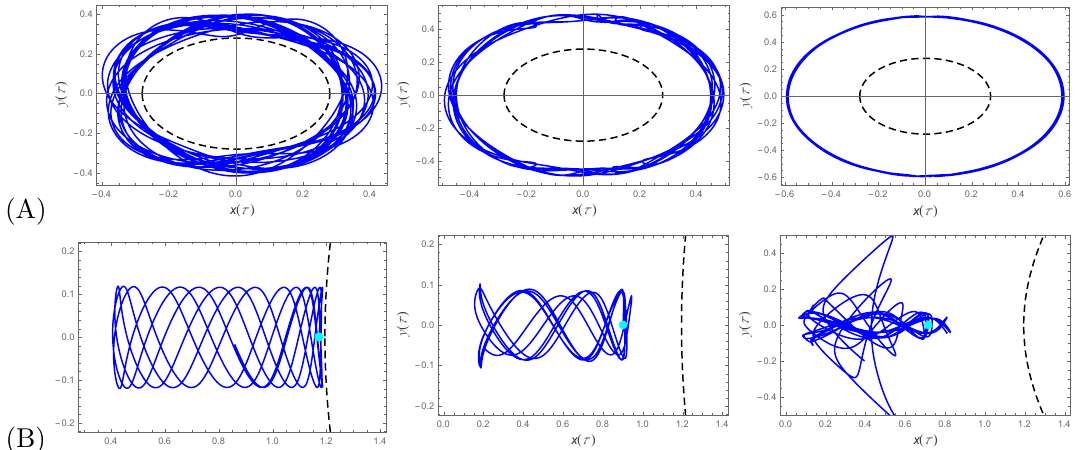
Figure 3 . Thermal horizon and hyperbolic scattering as generators of chaos. In (A) and (B), we show the orbits in the vicinity of the spherical and hyperbolic horizon, respectively, at the small temperature T = 0 : 01 and starting at increasing distances from the horizon. In (A), the further from the horizon, the more regular the orbit becomes. But in the hyperbolic geometry (B), the thermally-generated chaos is negligible; instead, the orbit becomes chaotic as it explores larger and larger area of the hyperbolic manifold. Hence for hyperbolic horizons, an additional, non-thermal generator of chaos exists: it is the hyperbolic scattering. Light blue dots are again the initial positions of the string origin ((cid:8) = 0).